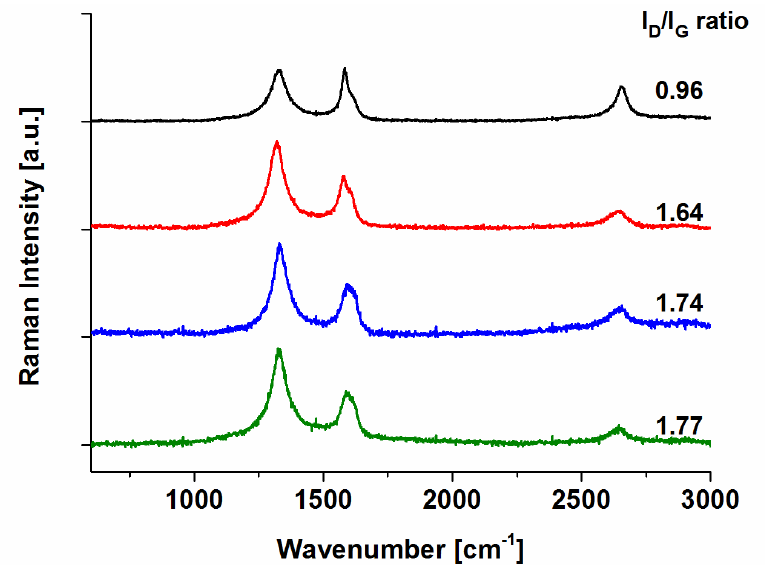
Figure 3. Raman spectra of p-CNO (black line), benz-CNO (red line), py-CNO (blue line) and py+-CNO (green